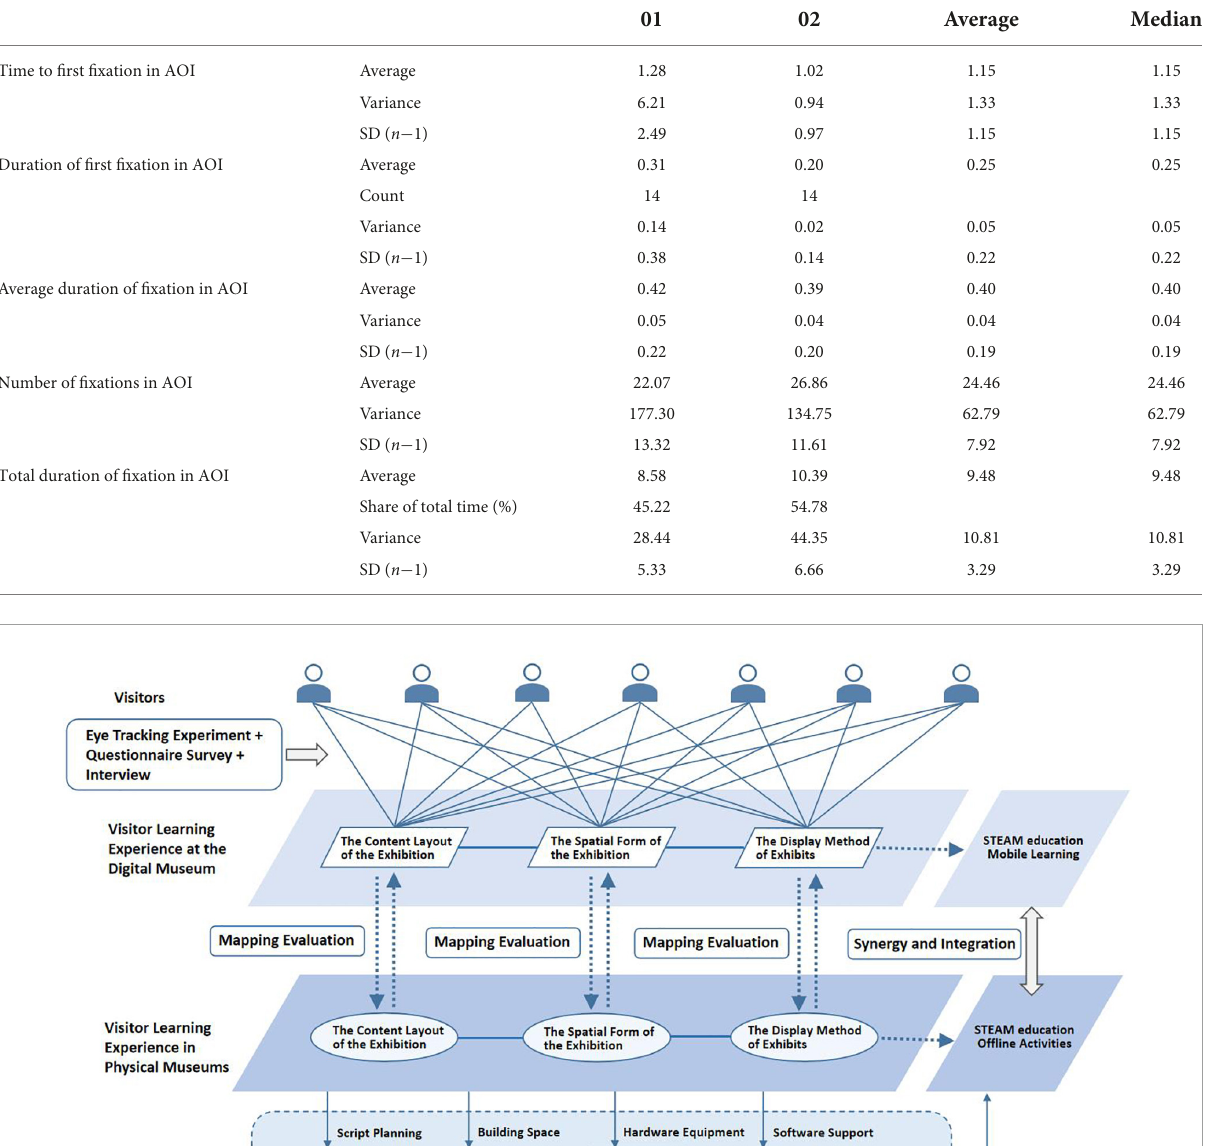
TABLE 4 The eye movement data statistics of the subjects in the AOI area.